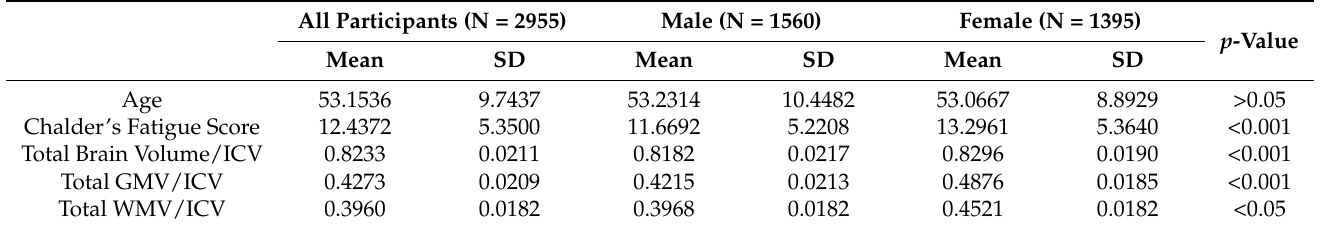
Table 1. Sex differences in age, Chalder’s fatigue questionnaire score, and several brain region volumes (divided and standardized based on intracranial volume).